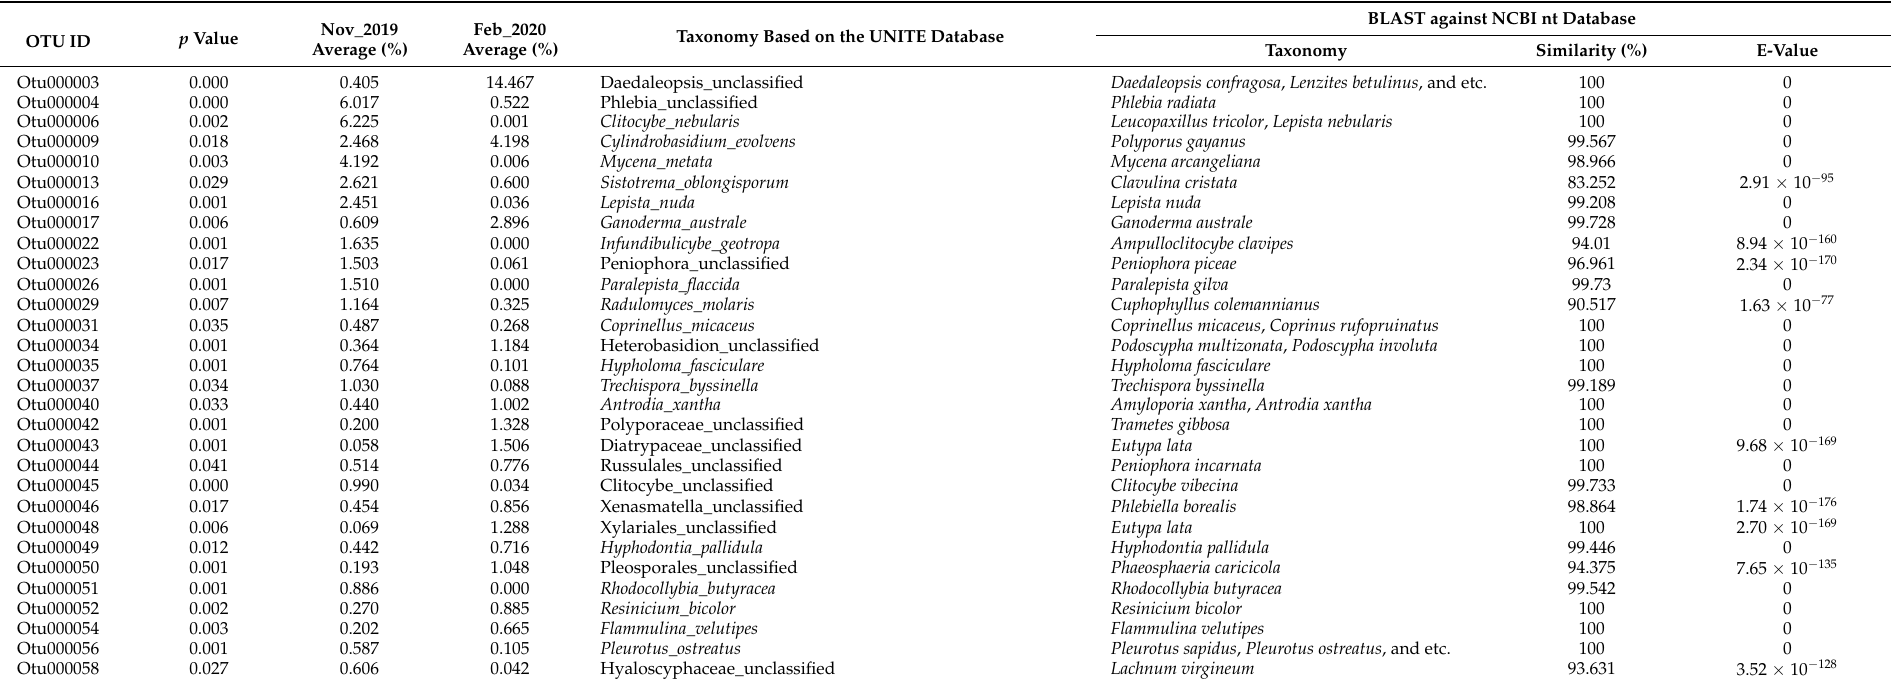
Table 3. t -test (or Wilcoxon test) results of the 30 most abundant fungal OTUs that shows significant difference in their relative abundance between the November 2019 samples and the February 2020 samples. Their taxonomic annotation based on the UNITE database and their BLAST result against NCBI nt database (best hit score, classified down to species level) are shown